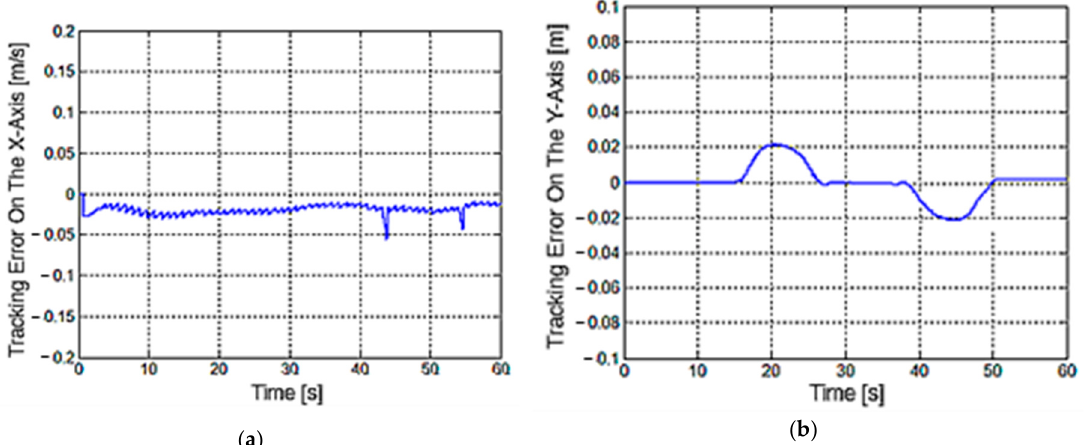
Figure 19. ( a ) X-axis and ( b ) Y-axis motion tracking errors for ARS PeopleBot, in absolute coordinates.